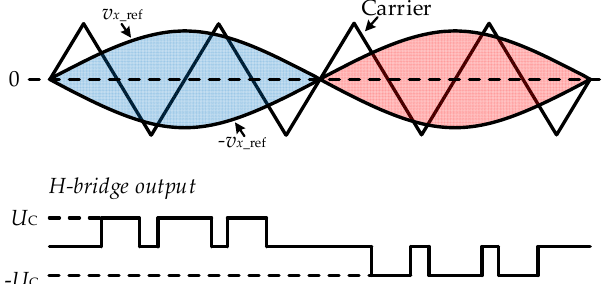
Figure 2. Unipolar double ‐ frequency pulse ‐ width ‐ modulation (PWM).